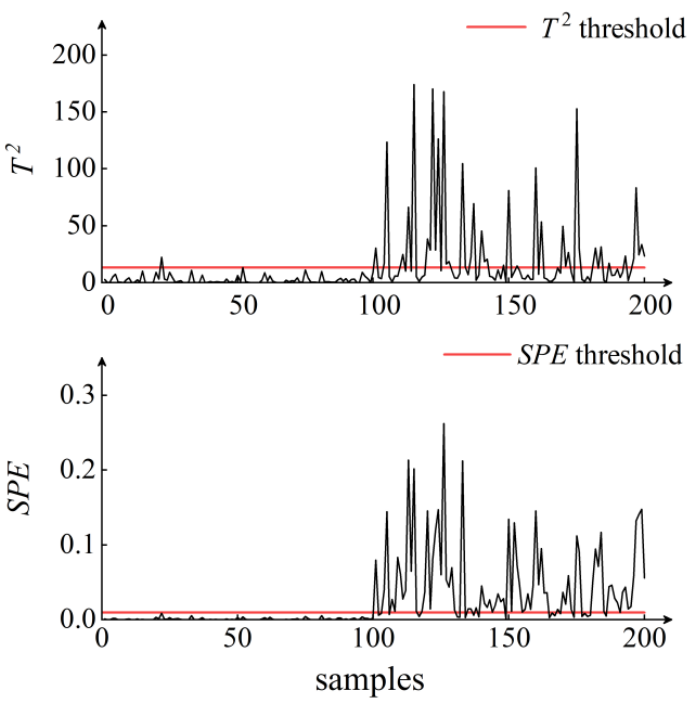
Figure 13. KPLS monitoring of sample 2.